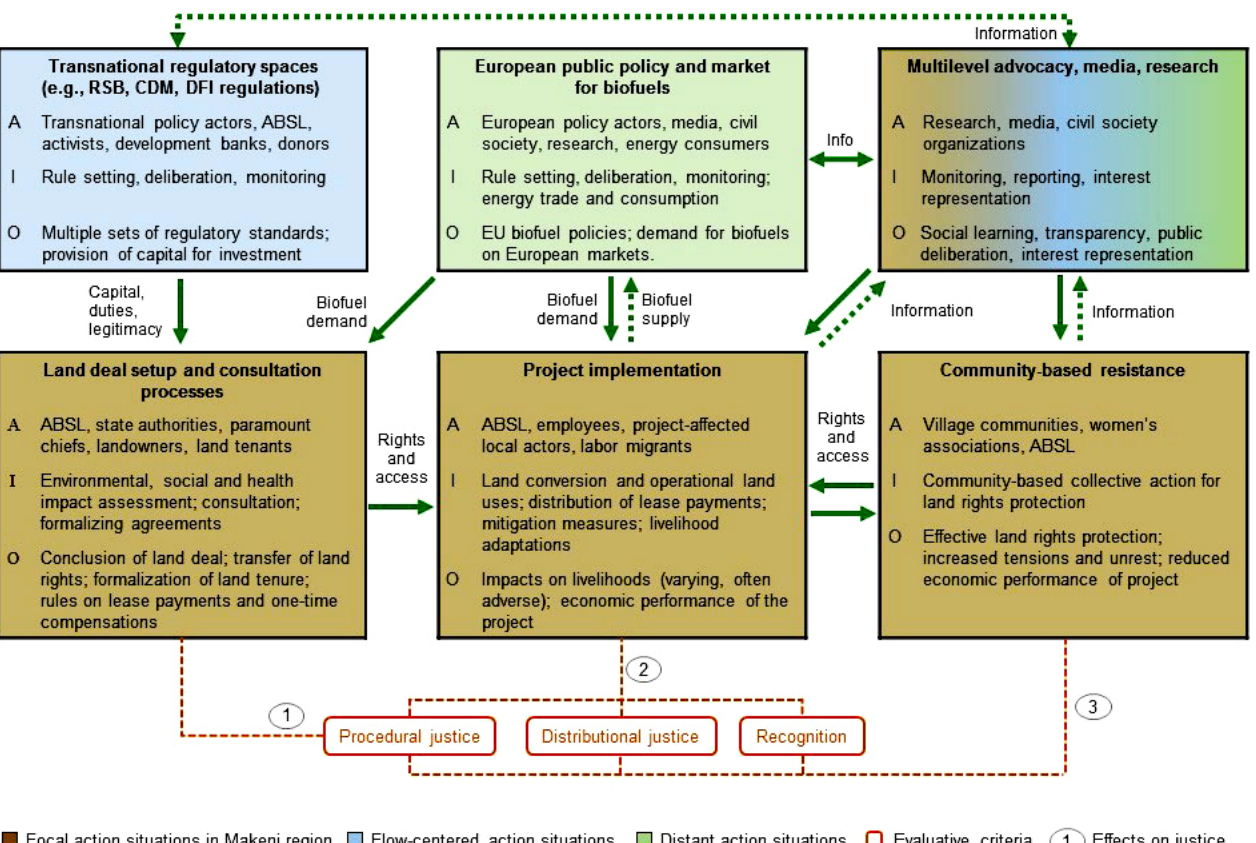
Fig. 5 . Network of action situations and land system performance in the Addax Bioenergy in Sierra Leone (ABSL) case. Source: Authors. Abbreviations: RSB: Roundtable on Sustainable Biofuels, CDM: Clean Development Mechanism, DFI: Development Finance